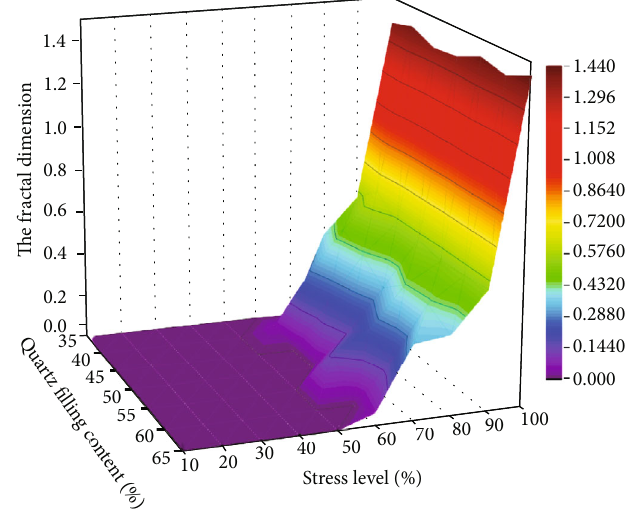
Figure 20: Relationship among the quartz content, stress level, and fractal